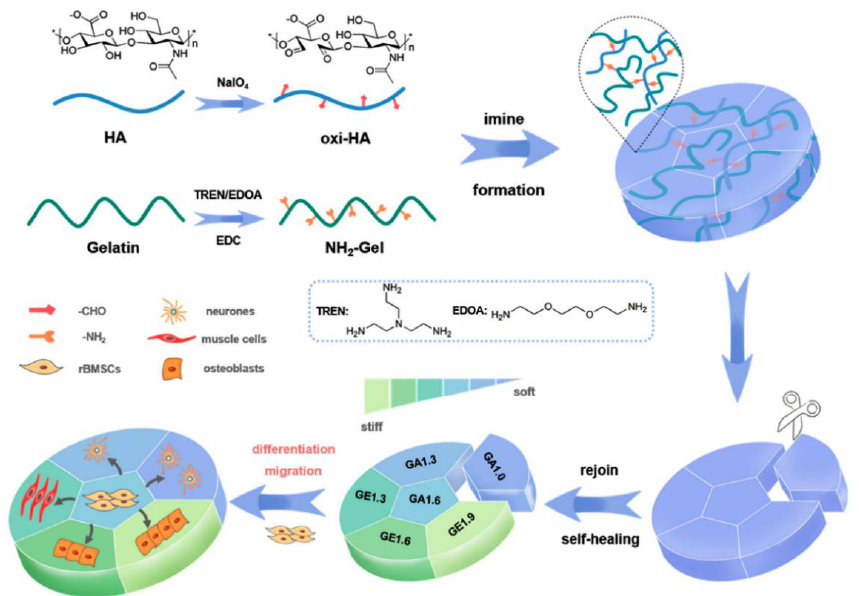
Figure 10. Schematic illustration of the gradient circular-patterned hydrogel for regulating cell behaviors. To build a hydrogel model containing cell-regulating cues, hydrogels with gradient stiffnesses are spliced into a circular pattern based on their self-healing performance. (Reprinted/adapted with permission from Ref. [80], 2022, Wang et al.).